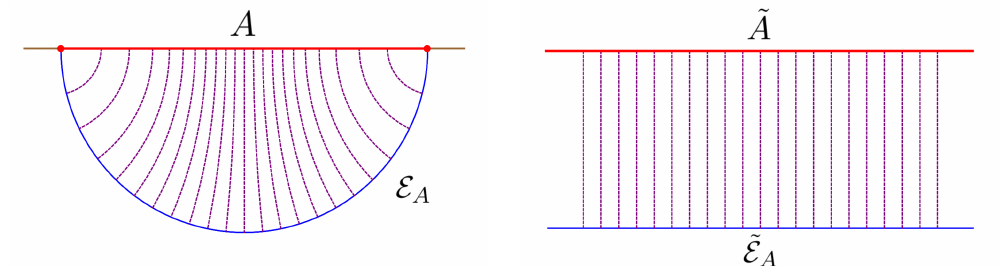
Figure 7: The left figure is extracted from [ 54 ] , licenced under CC-BY 4.0. Here we have chosen a time slice and fixed all the angular coordinates in the original Poincare AdS as well as the hyperbolic black hole (cid:222) AdS (34). The dashed purple lines are d + 1 d + 1 the intersection between modular slices and the time slice, they are also geodesics normal to the RT surface E and the horizon of the hyperbolic black holes ˜ E . A A